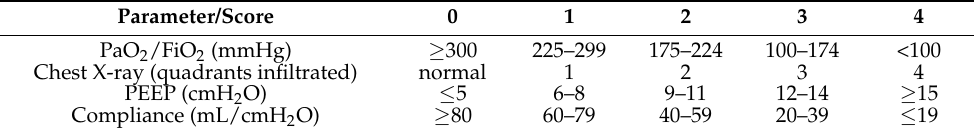
Table 3. Murray score for the initiation of VV-ECMO in acute respiratory failure [34].